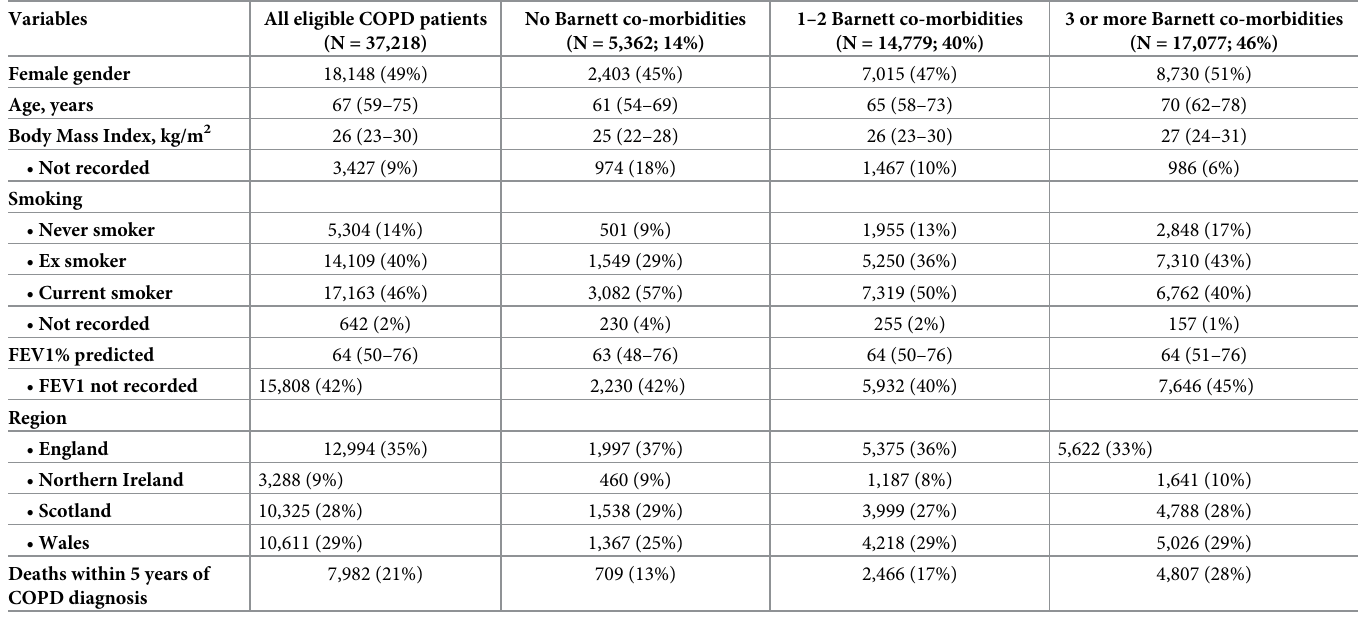
Table 2. Demographics and clinical characteristics of the unlinked group (those not linked to hospital and ONS mortality data).